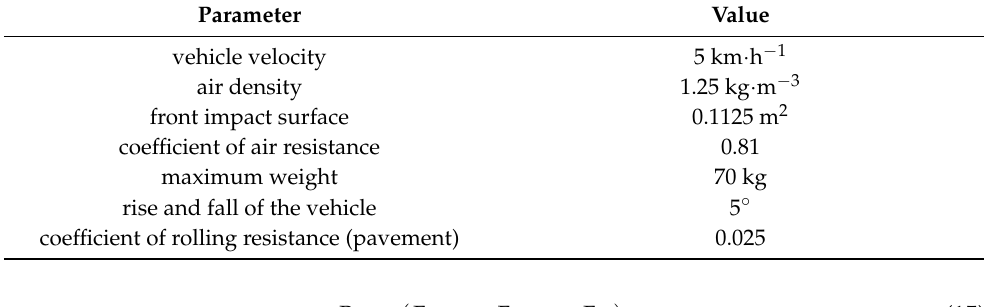
Table 3. Selected parameters for calculating the power of electric motors.